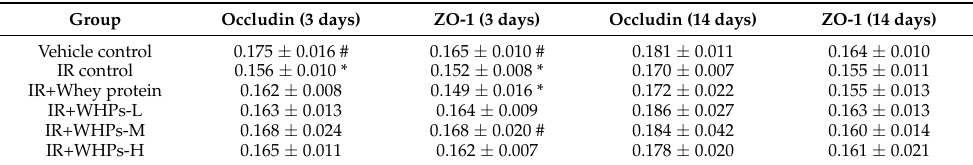
Table 10. Effect of WHPs on the expression of occludin and ZO-1 proteins (AOD, n = 12, x ± s).